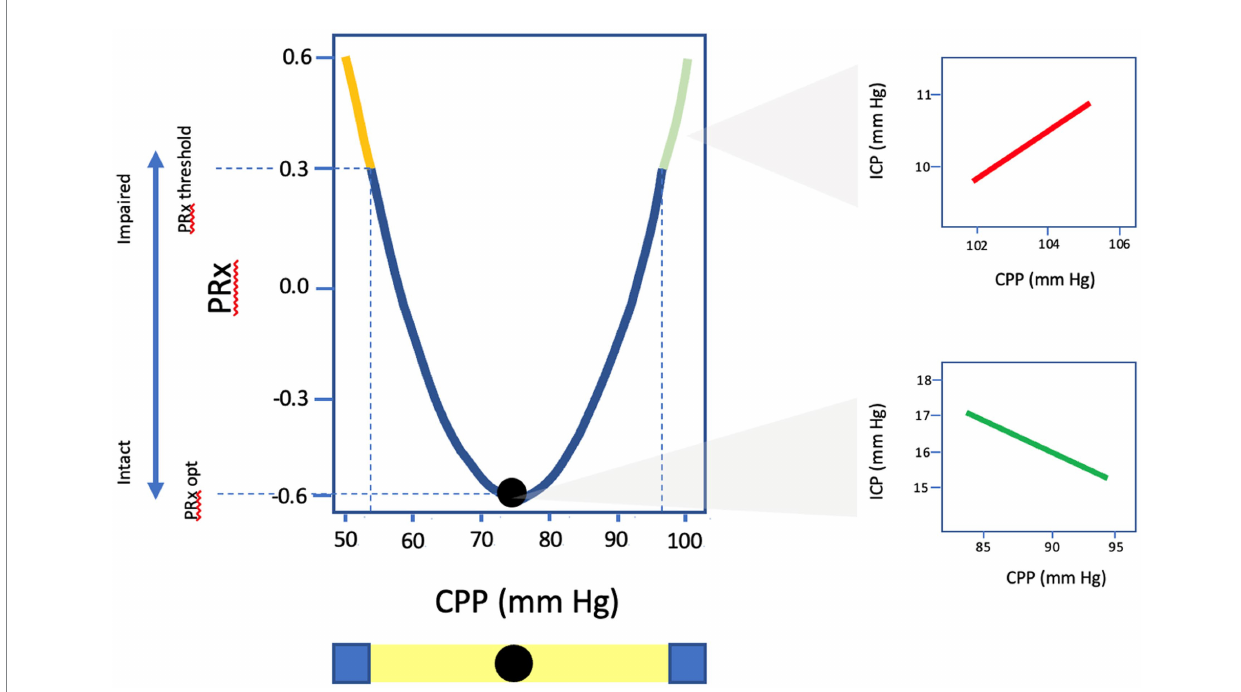
FIGURE 4 Graphic representation of U-shaped curve of PRx values as a function of CPP. CPP opt identified as the CPP value with the lowest associated PRx and most optimal autoregulatory state. PRx, pressure reactivity; CPP, cerebral perfusion pressure; ICP, intracranial